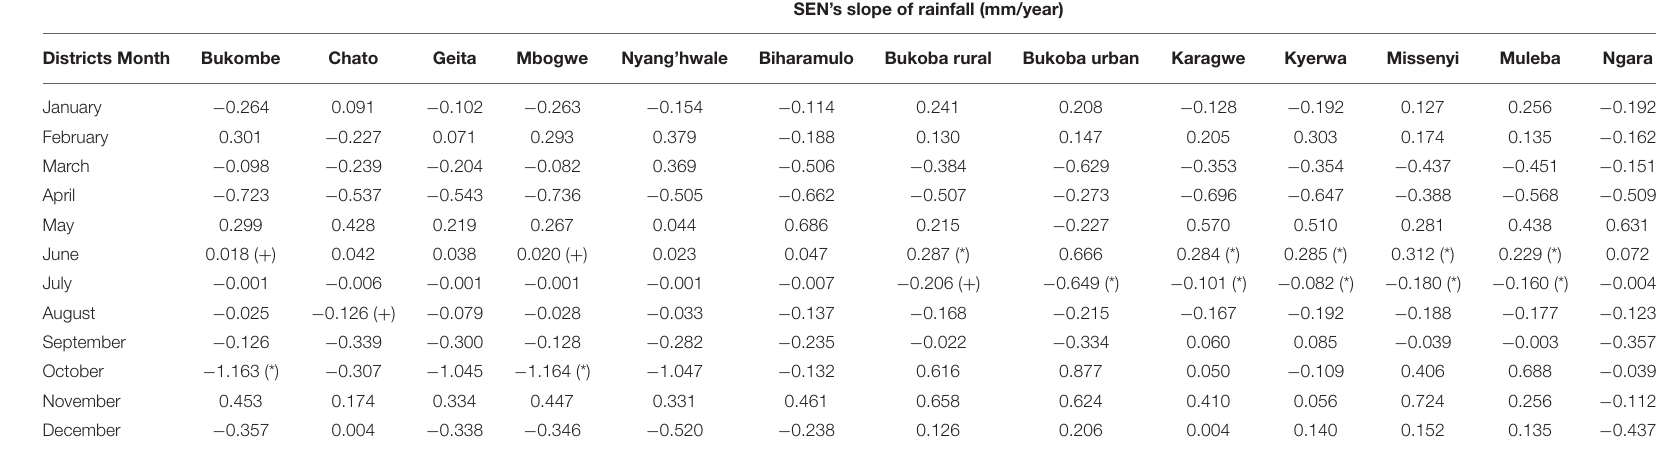
TABLE 2 | The gradient of the annual cycles of rainfall during the historical climate condition